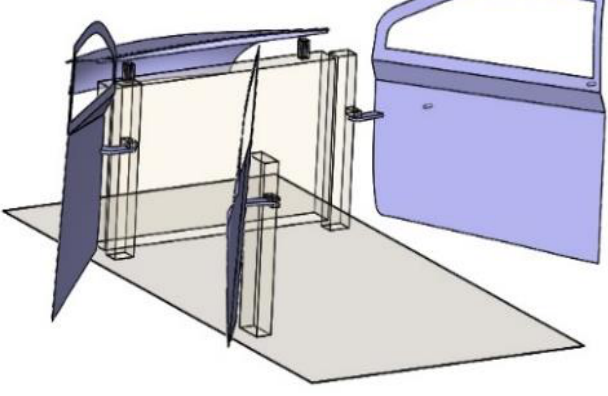
Fig. 11. Show the attachment of hinges with the pillars